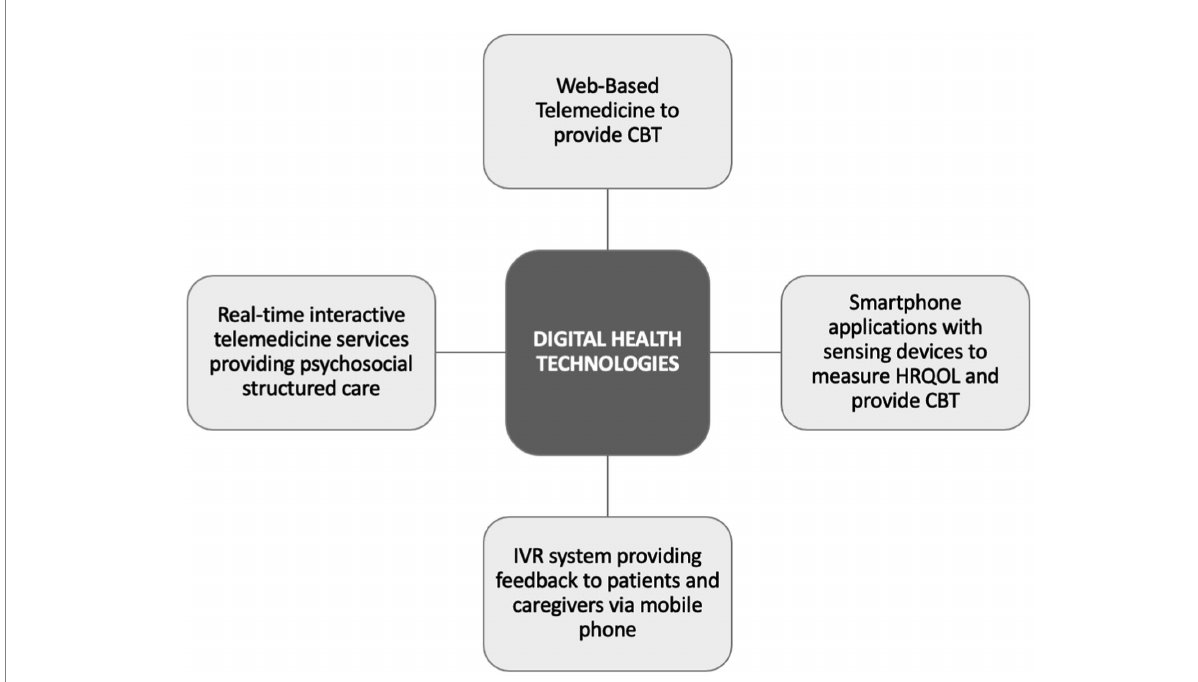
FIGURE 1 Scheme of main applications of digital health technologies in heart failure for biopsychosocial